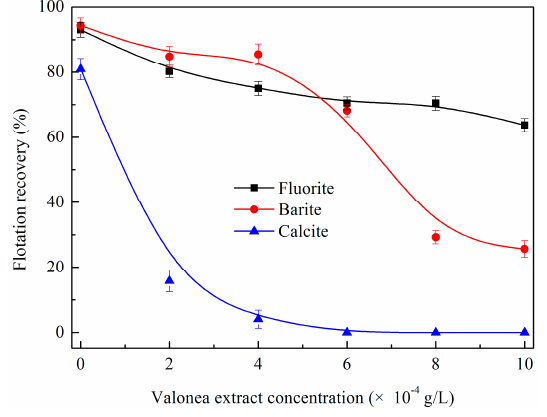
Figure 4. Effects of valonea extract dosage on flotation recovery (sodium oleate dosage = 4 × 10 − 5 mol/L, pH = 7).